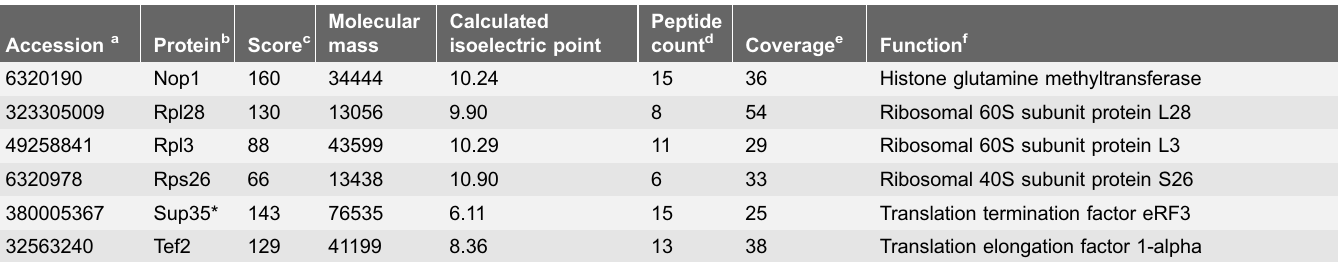
a GI number. b Standard abbreviations of protein names are indicated. c MASCOT protein score. d Number of unique peptides matched to mass peaks. e Sequence coverage in percent. f Data are presented in ‘‘Saccharomyces Genome Database’’ (http://www.yeastgenome.org/). *Detected only in the GT81-1C [ PSI + ][ PIN + ]